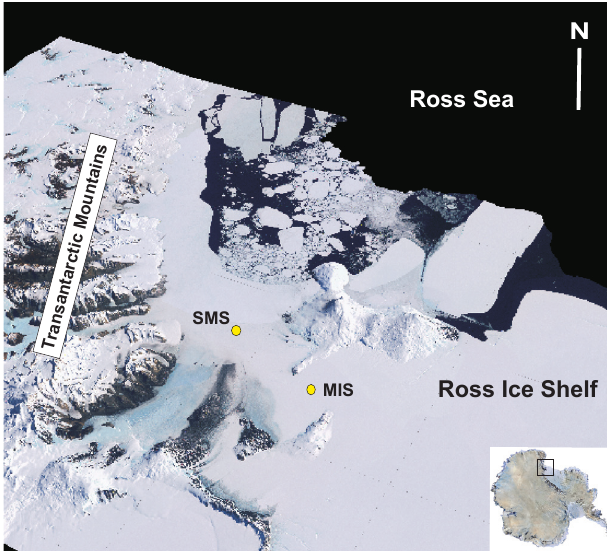
Figure 2. Satellite image of the McMurdo Sound region, including location of the Southern McMurdo Sound (SMS) and McMurdo Ice Shelf (MIS) drill sites.